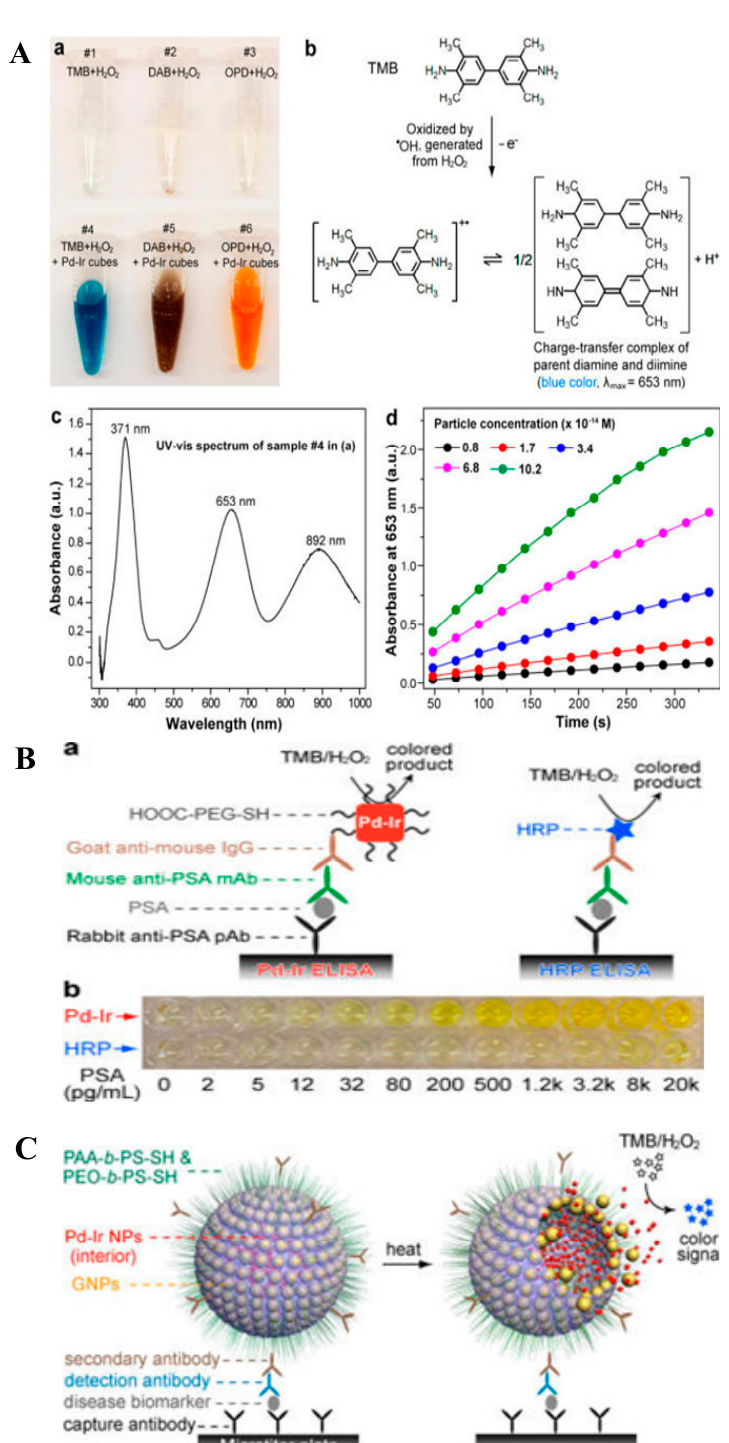
Figure 2. ( A ) Peroxidase-like activity of Pd-Ir cubes. Reproduced with permission from [54]. Copyright American Chemical Society, 2015. ( B ) Detection of prostate surface antigen (PSA) with Pd-Ir cubes-based enzyme-linked immunosorbent assay (Pd-Ir ELISA) and conventional horseradish peroxidase-based ELISA (HRP ELISA). Reproduced with permission from [54]. Copyright American Chemical Society, 2015. ( C ) Schematic illustration of the utilization of Pd − Ir NPs@GVs based ELISA for the detection of disease biomarkers. Reproduced with permission from [55]. Copyright American Chemical Society, 2017.